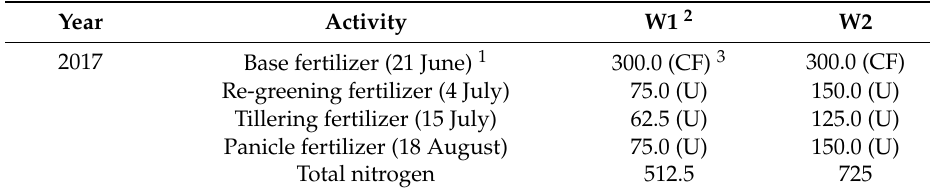
Table 2. Time and amount of fertilization (kg hm − 2